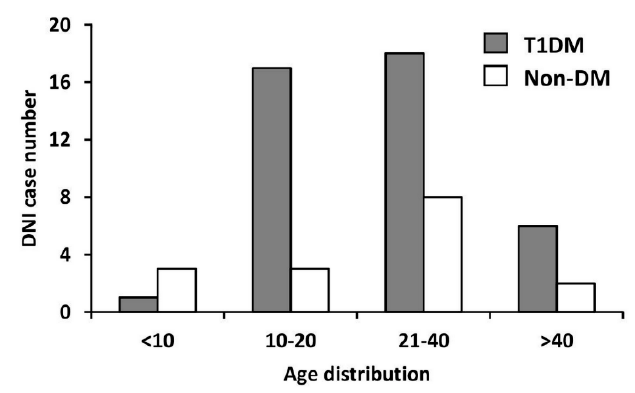
Figure 3. Age distribution of DNI in the T1DM and non-DM cohorts. The peak age of DNI occurrence in the non-DM cohort was 21–40 years, while those in the T1DM cohort were 10–20 years and 21–40 years.